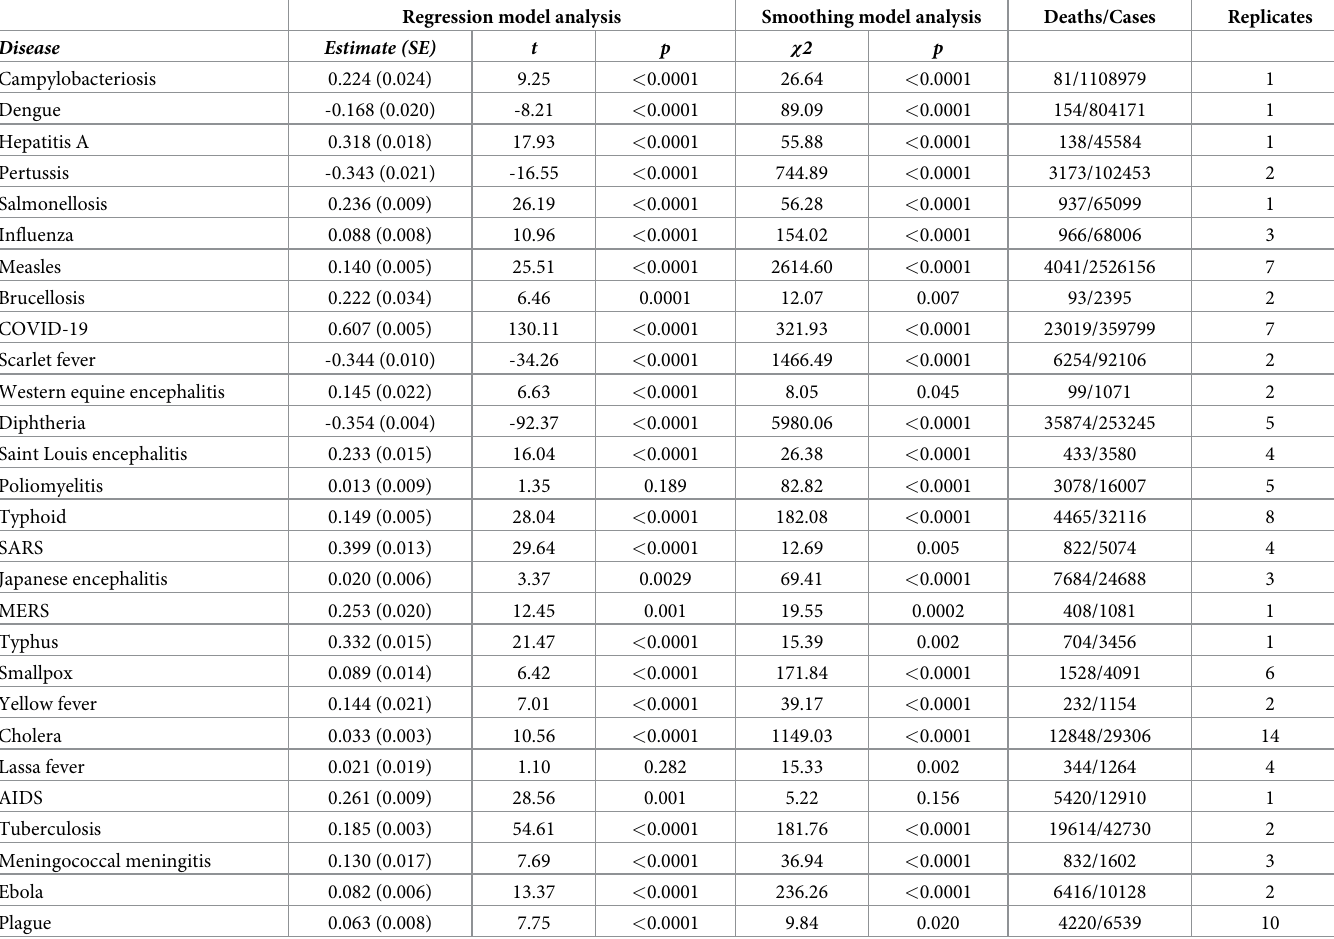
Table 1. Generalized additive models (GAMs) investigating the shape of the relationship between CFR of 28 human infectious diseases and age. For each model, we report the results for the linear (regression model analysis) and the non-linear (smoothing model analysis) components. The sign of the estimate indicates whether the lin- ear trend was positive or negative. The models were run using a binomial distribution of errors (number of deaths/number of cases). Diseases are ordered by increasing val- ues of CFR (deaths/cases). The column Replicates indicates the number of replicated datasets per disease. After a sequential Bonferroni correction, the non-linear trend for Western equine encephalitis was not statistically